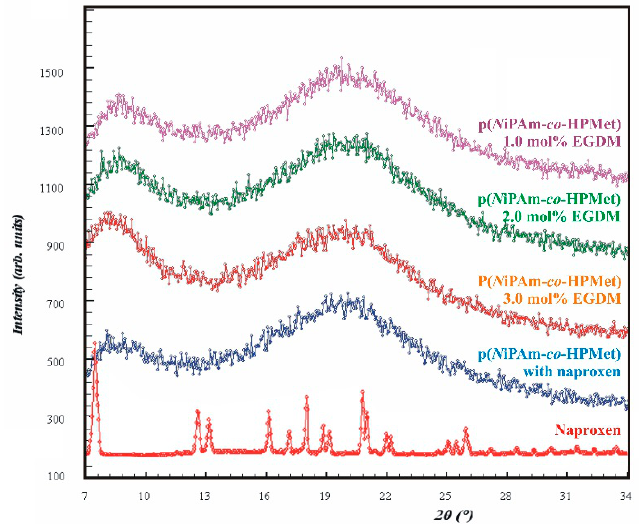
Figure 4. XRD diffractograms of: the copolymers p( N iPAm-co-HPMet) with 1.0 mol%, 2.0 mol% and 3.0 mol% of cross-linker EGDM; p( N iPAm-co-HPMet) with 1.0 mol% of EGDM with incorporated naproxen; and naproxen. XRD diffractograms of naproxen and p( N iPAm-co-HPMet) hydrogel sample with 1.0 mol% of EGDM after naproxen incorporation were also presented in